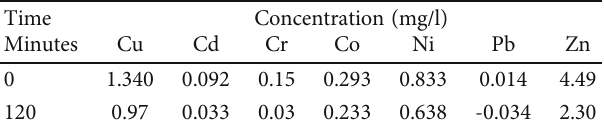
Table 2: Heavy metal concentration after di ff erent time intervals.